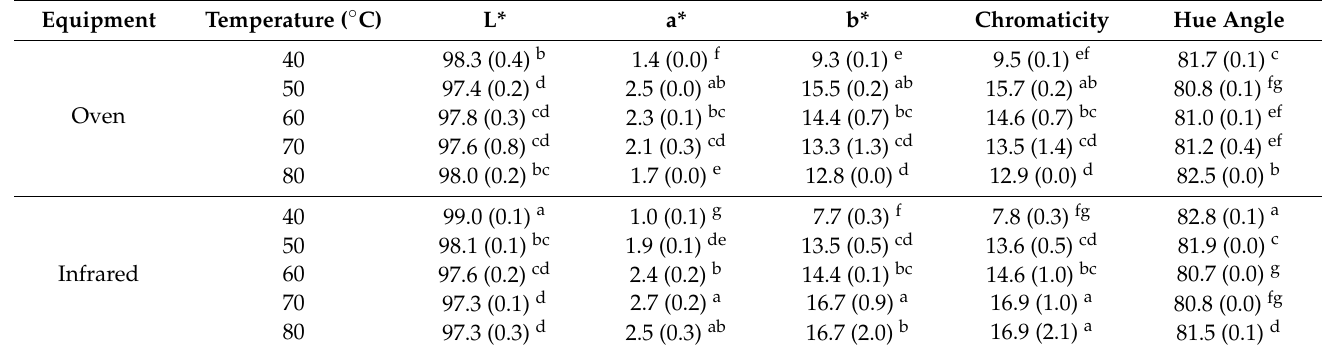
Table 1. Influence of drying temperature on the color of the olive leaf infusions. Data are expressed as the mean value of triplicate. Standard deviation in parentheses. Different lowercase letters indicate significant differences according to Duncan’s multiple range test ( p <